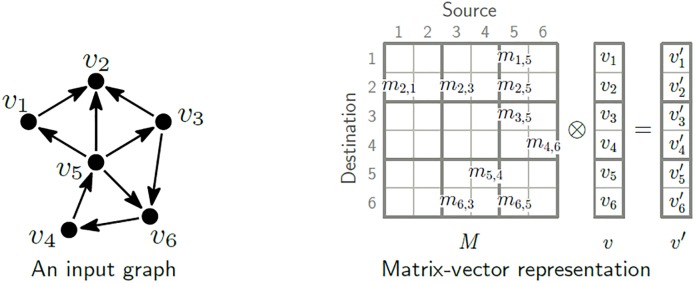
Matrix-vector representation of a directed graph.The matrix M and the vector v correspond to the edge set and the vertex set of the graph, respectively. An iteration of graph processing is represented as a matrix-vector multiplication with generalized operations.